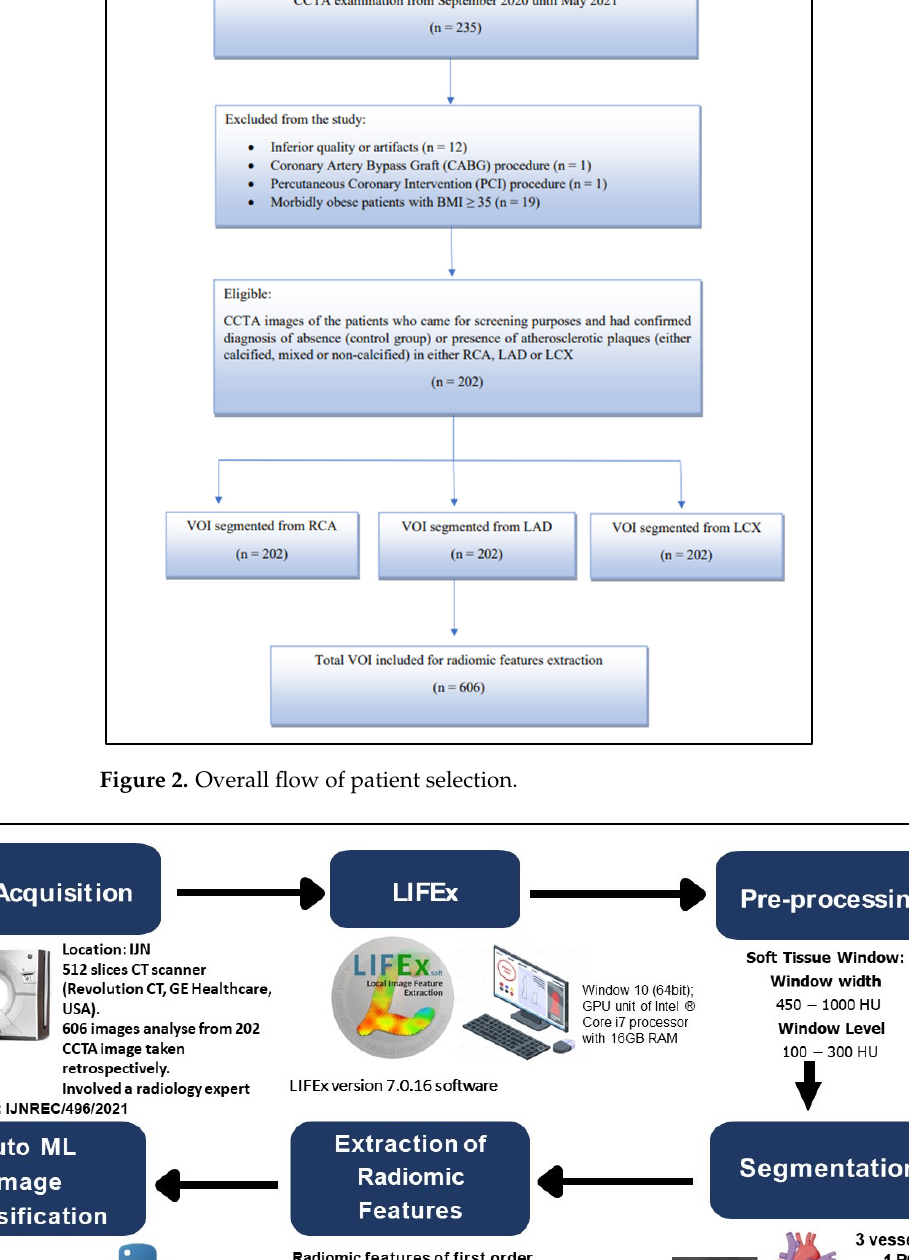
Figure 3. Overall research workflow.